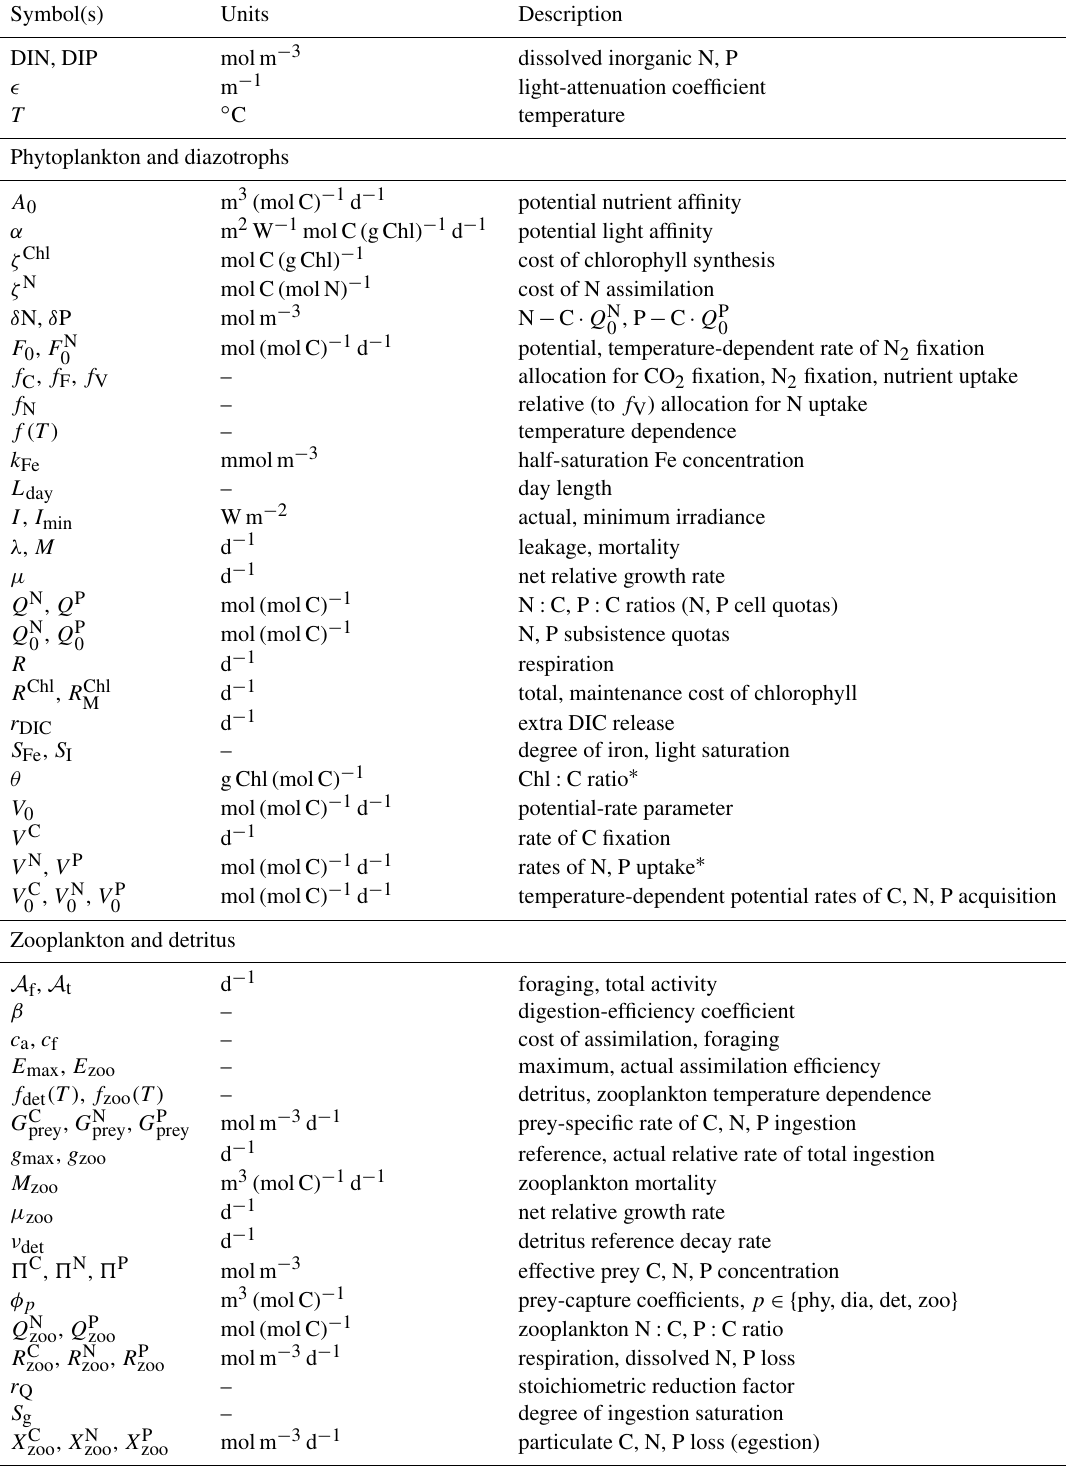
Table 1. Parameters and variables of the optimality-based plankton compartments.